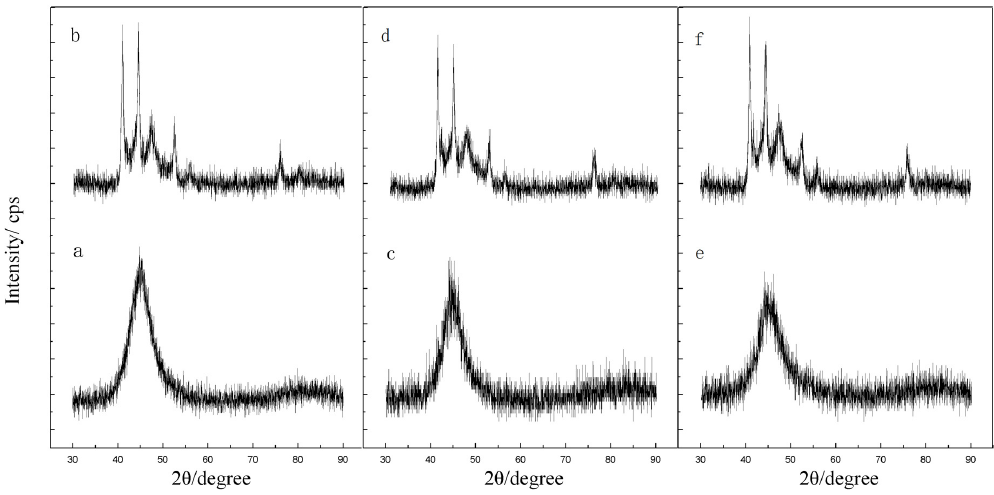
Figure 3. XRD patterns of coatings deposited at different current. ( a ) DC as deposited; ( b ) DC heat treated at 400 °C; ( c ) SP as deposited; ( d) SP heat treated at 400 °C; ( e ) DP as deposited; ( f ) DP heat treated at 400 °C.